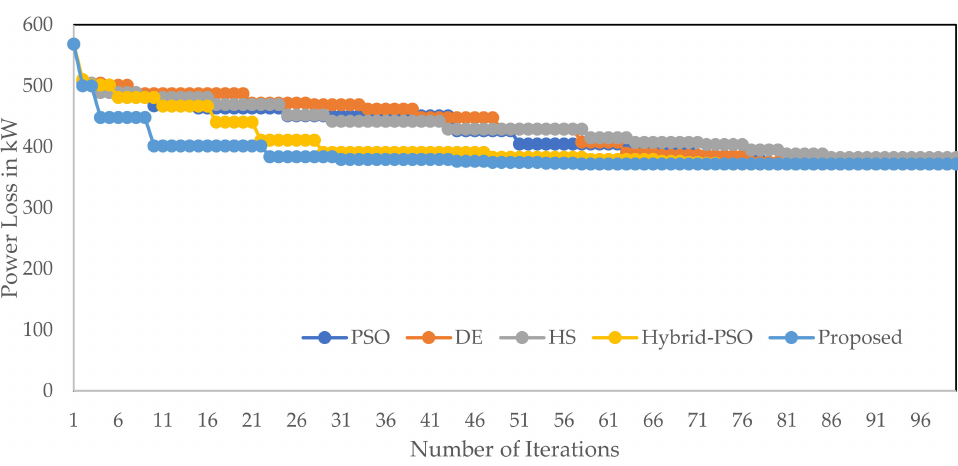
Figure 13. Convergence characteristic of the algorithms for test case 2 under SFC at zone